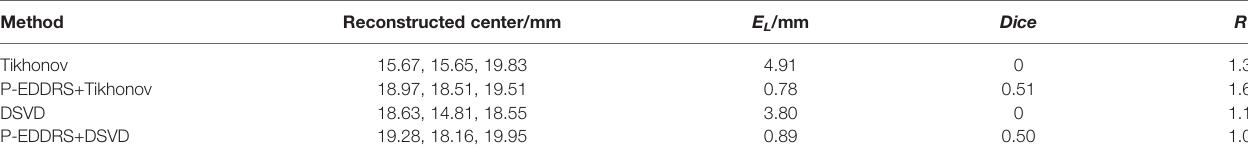
TABLE 6 | Quantitative evaluation results of the CLT pseudotumor in vivo experiments.